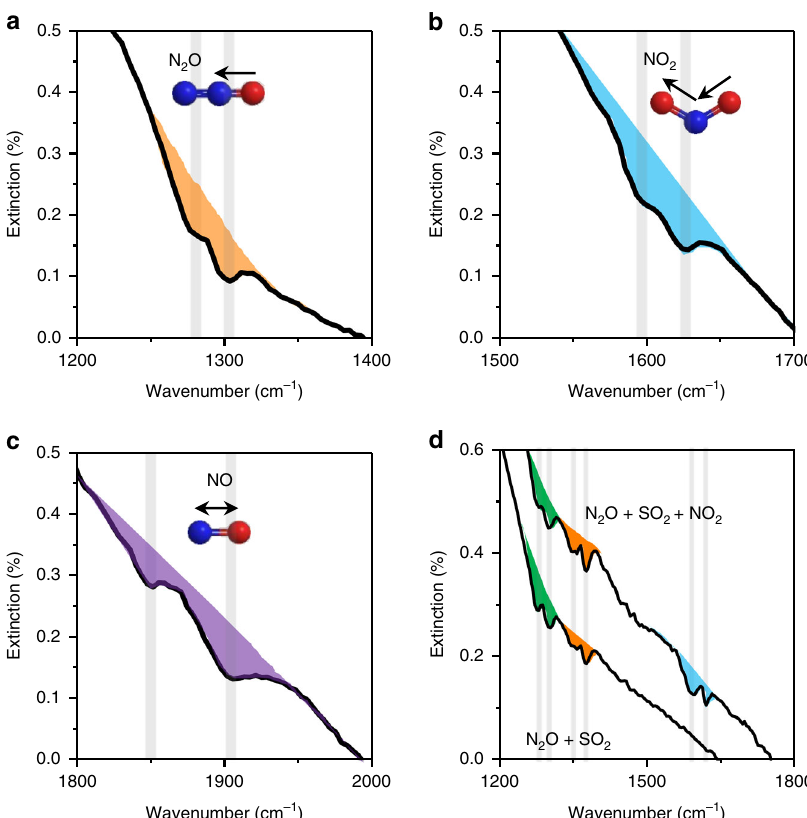
Fig. 3 Identi fi cation of different nitrogen oxides. a – c Extinction spectra of graphene in the presence of N 2 O, NO 2 , and NO, respectively. The rotational – vibrational modes are marked with vertical lines. d Extinction spectra of graphene in the presence of two gas mixtures, one consisting of SO 2 and N 2 O, and the other of SO 2 , N 2 O, and NO 2 . The graphene ribbon widths in a – c were 80, 60, and 40 nm, respectively, with a fi lling factor of 90%, Δ V CNP of 30 V, and concentration of N 2 O of 8000 ppm, and NO 2 and NO of 4000 ppm at 1 atm